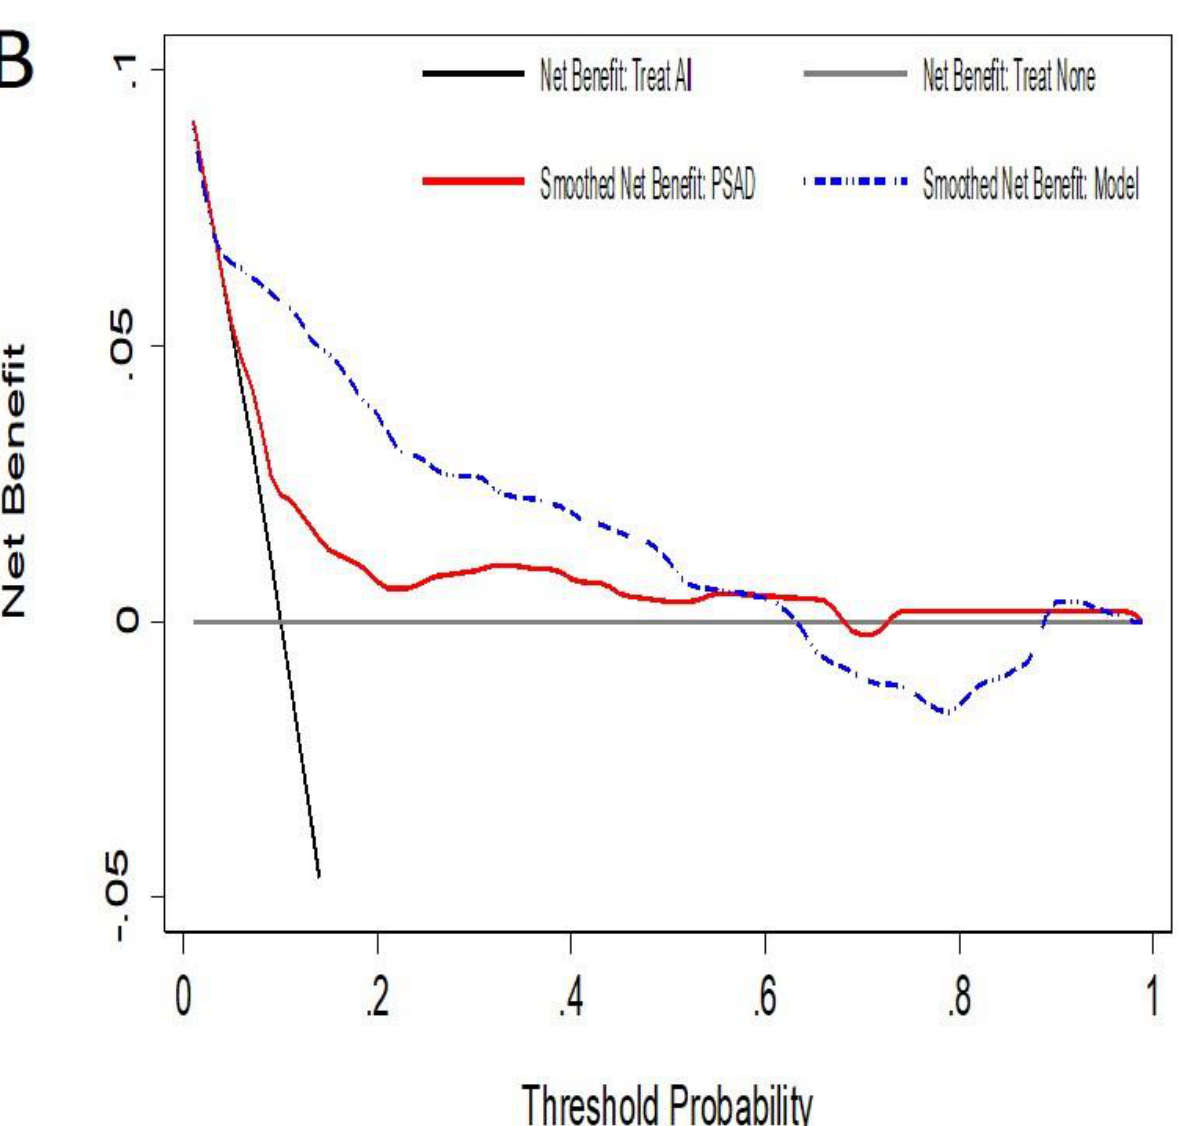
Figure 2. The ROC curves and AUCs show the efficacy of mPSAD (PSAD in the graphic) and MRI- PMbdex (model in the graphic) in detecting csPCa in men with PI-RADS < 3 ( A ). The DCAs showing the net benefit of mPSAD and MRI-PMbdex over performing biopsies on all men according to the csPCa probability threshold ( B ).